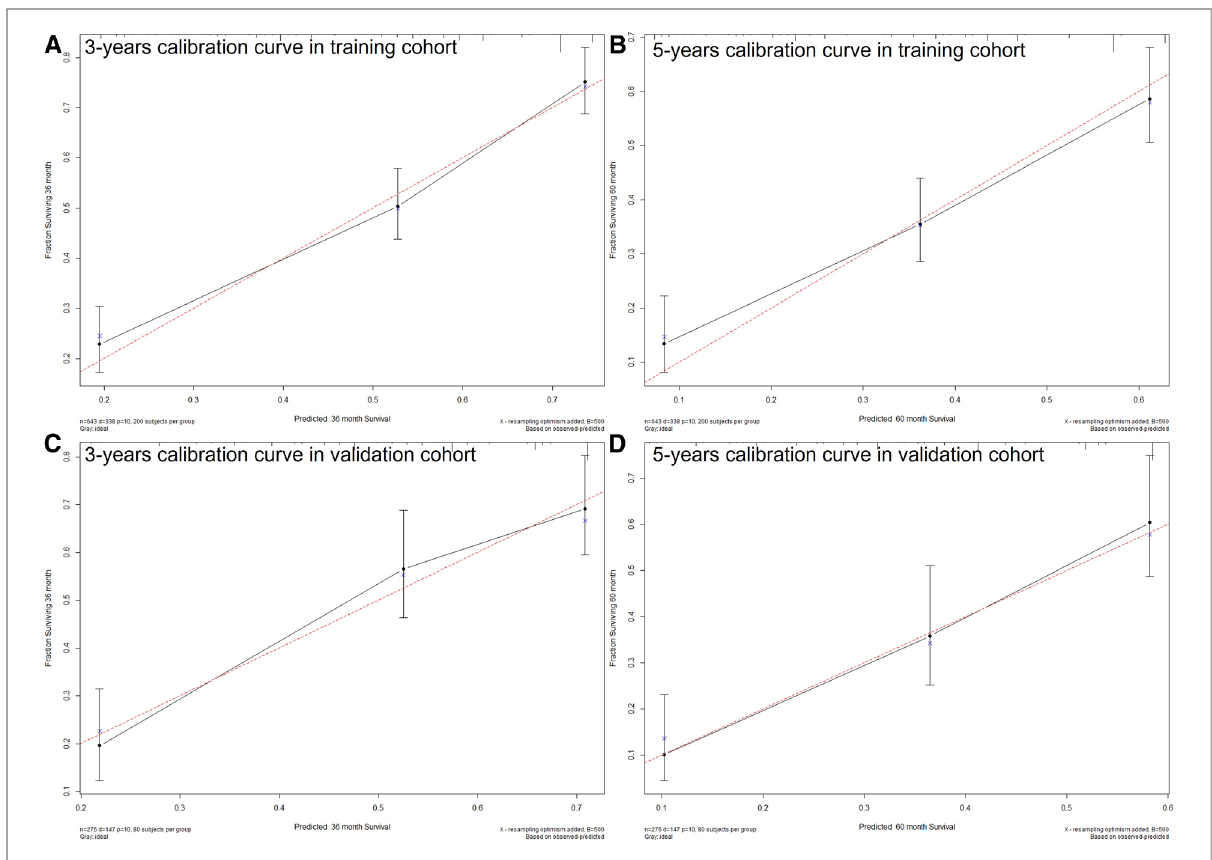
FIGURE 5 The calibration plots show excellent agreement between observed outcomes and predicted survival probabilities. ( A ) 3 years in training cohort; ( B ) 5 years in training cohort; ( C ) 3 years in validation cohort; ( D ) 5 years in validation